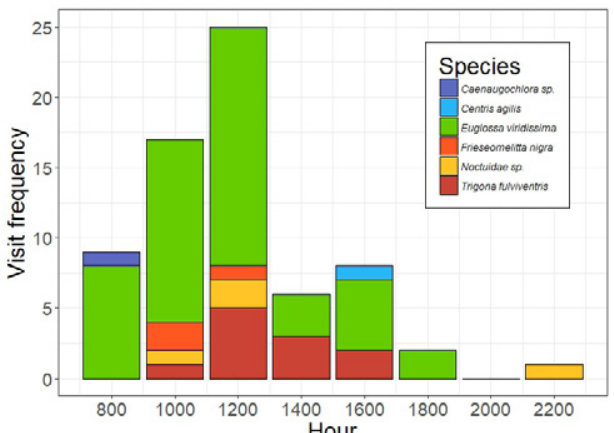
Fig 2. Assemblage of floral visitors and their frequency per hour in Martynia annua